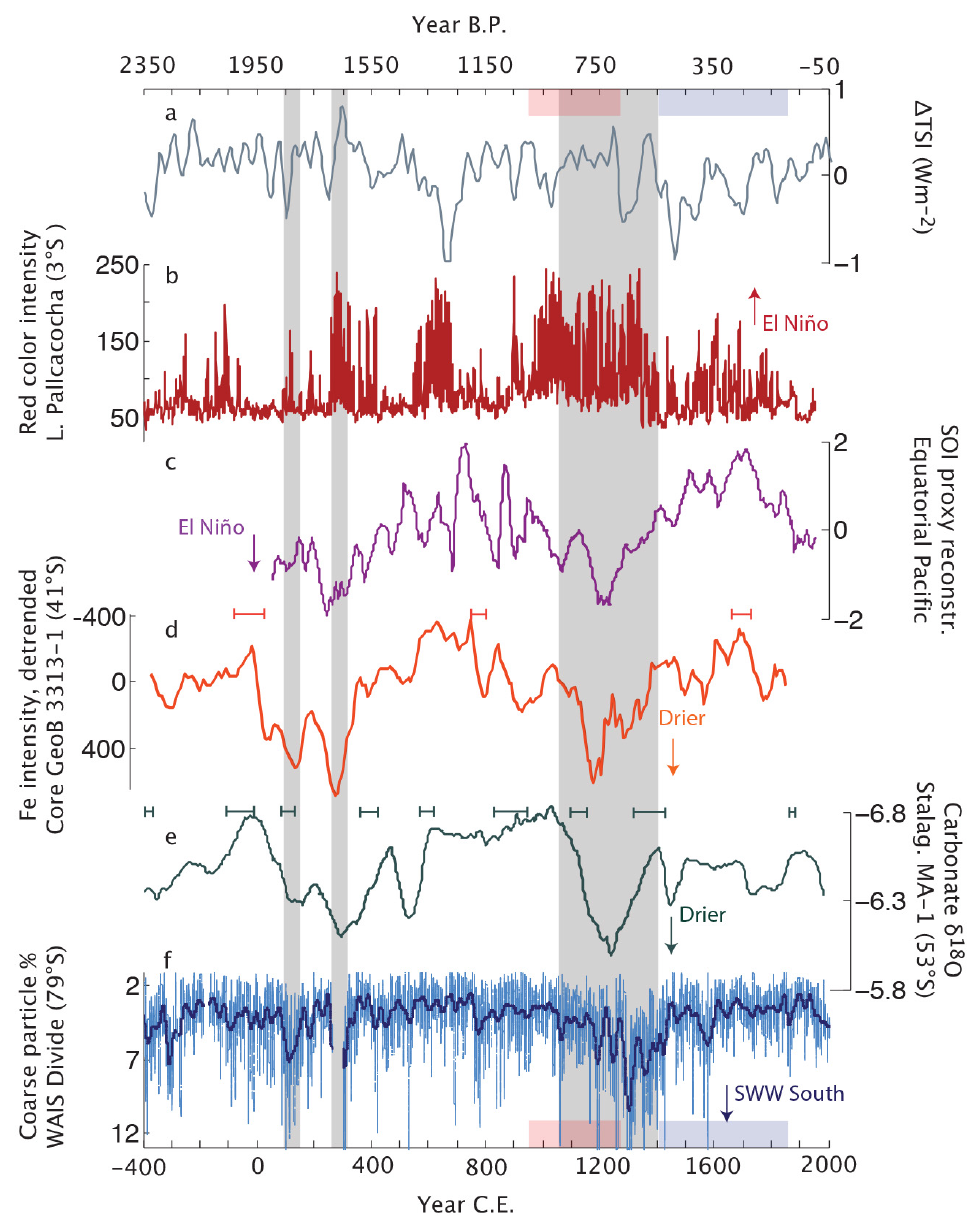
Figure 8. Paleoclimate reconstructions from the eastern Pacific region: (a) Change in total solar irradiance (TSI) based on variability of cosmogenic 10 Be, the production of which is modulated by the strength of the open solar magnetic field (Steinhilber et al., 2009). (b) Red color intensity record of sediments from Laguna Pallcacocha, Ecuador; greater color intensity indicates more El Niño-driven high precipitation events (Moy et al., 2002). (c) Southern Oscillation Index (SOI) precipitation-based reconstruction; negative values indicate a more El Niño-like state (Yan et al., 2011). (d) Detrended iron intensity record from marine sediment core GeoB 3313-1 on an inverted axis (Lamy et al., 2001). Lower values suggest more humid conditions. Orange error bars indicate published 14 C age control points and associated 1 σ AMS analytical error (F. Lamy, personal communication, 2014). (e) δ 18 O of stalagmite MA1 on an inverted axis. Lower values indicate an increased drip rate, driven by higher precipitation (Schimpf et al., 2011). Green error bars show positions and 2 σ error of U /Th ages. (f) WAIS Divide coarse particle percentage (this work) on an inverted axis, using timescale WDC06A-7. Data sets are plotted on their own published timescales. Gray bars indicate intervals of inferred southerly position of the SWW in the eastern Pacific, based on our interpretation of the CPP and South American precipitation reconstructions. Red and blue bars indicate the MCA and LIA intervals, respectively.